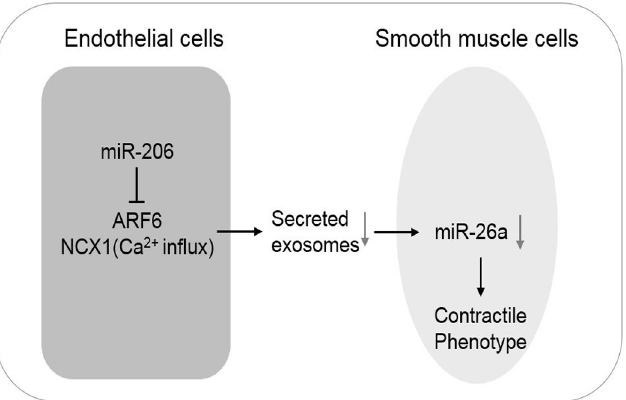
Fig 1. Graphical Abstract. Endothelial cells regulate the SMC phenotype by modulating the quantity of exosomes through the miR-206/ARF6 and NCX1/exosome axis.